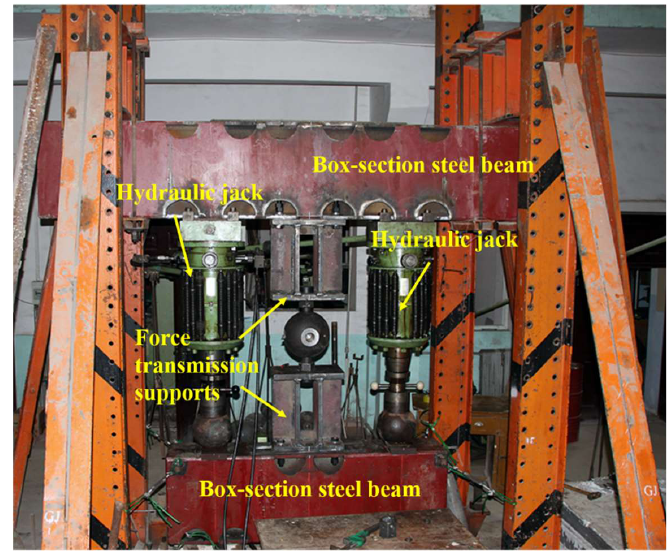
Figure 6. The fatigue testing machine and the loading device.